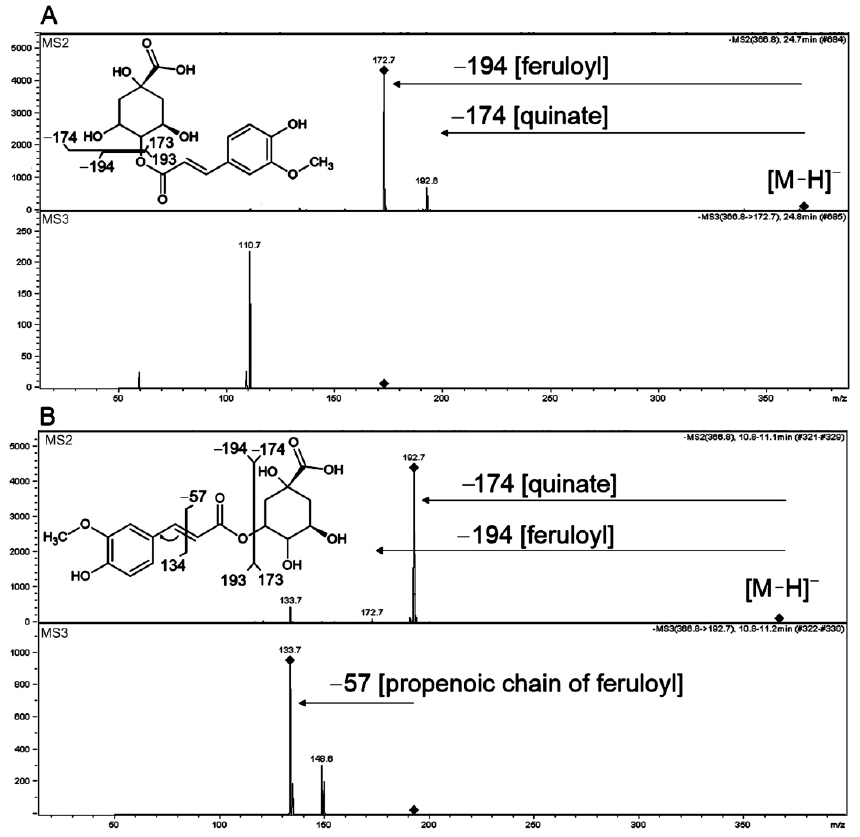
Figure 4. Low resolution MS2 and MS3 fragmentation spectra obtained in negative ionization of isomeric hydroxycinnamoyl-quinic acid (HQA) conjugates with hydroxycinnamic acids. ( A ) com- pound 43 , 4-feruloylquinic acid, ( B ) compound 26 , 5-feruloylqiunic acid. Postulated structures and proposed simplified fragmentation schemes are shown. The product ions subjected to fragmentation in MS3 or MS4 are indicated with turned squares at the ion apexes.